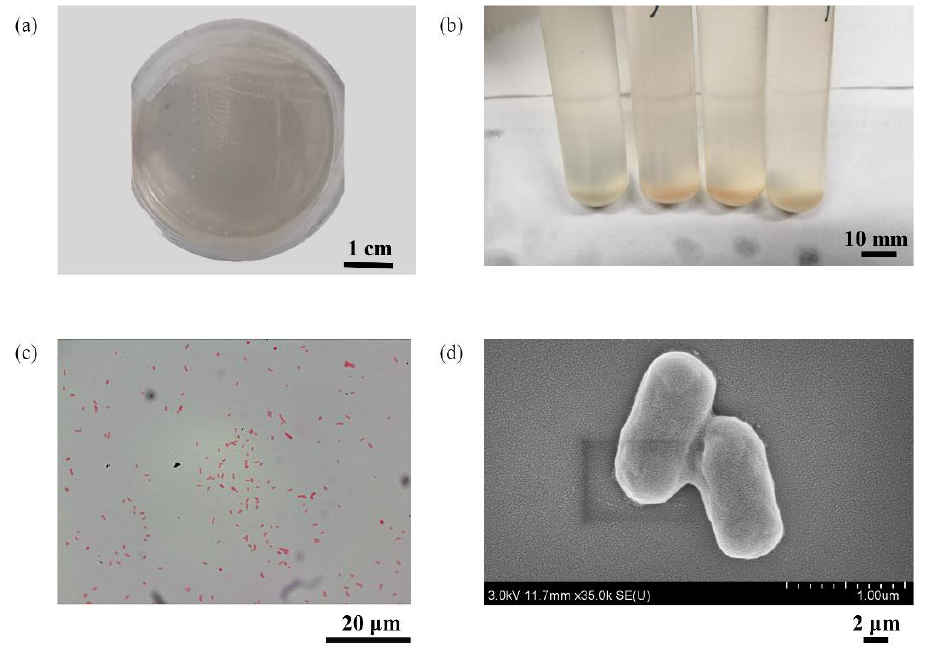
Figure 1. P. stutzeri colony ( a ); P. stutzeri liquid culture ( b ); P. stutzeri Gram staining ( c ); P. stutzeri SEM ( d ).